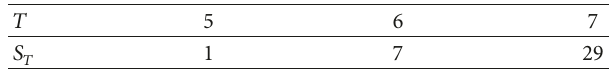
Table 1: Total number of mass distribution vectors calculated by